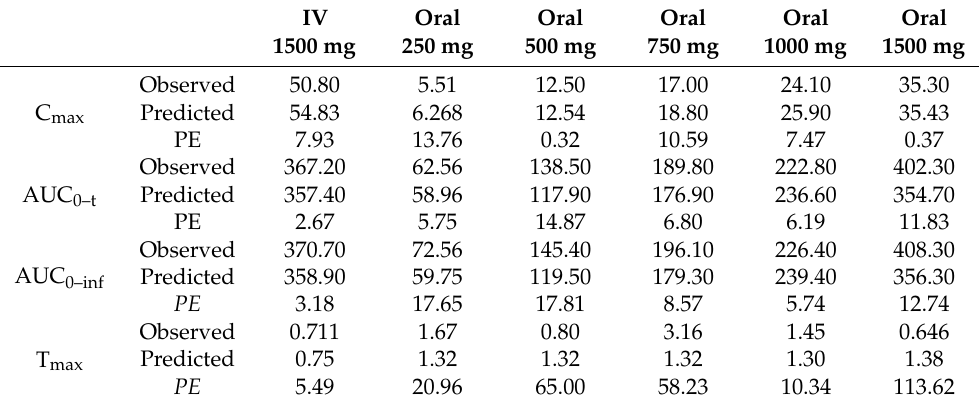
Table 5. Statistical table of prediction